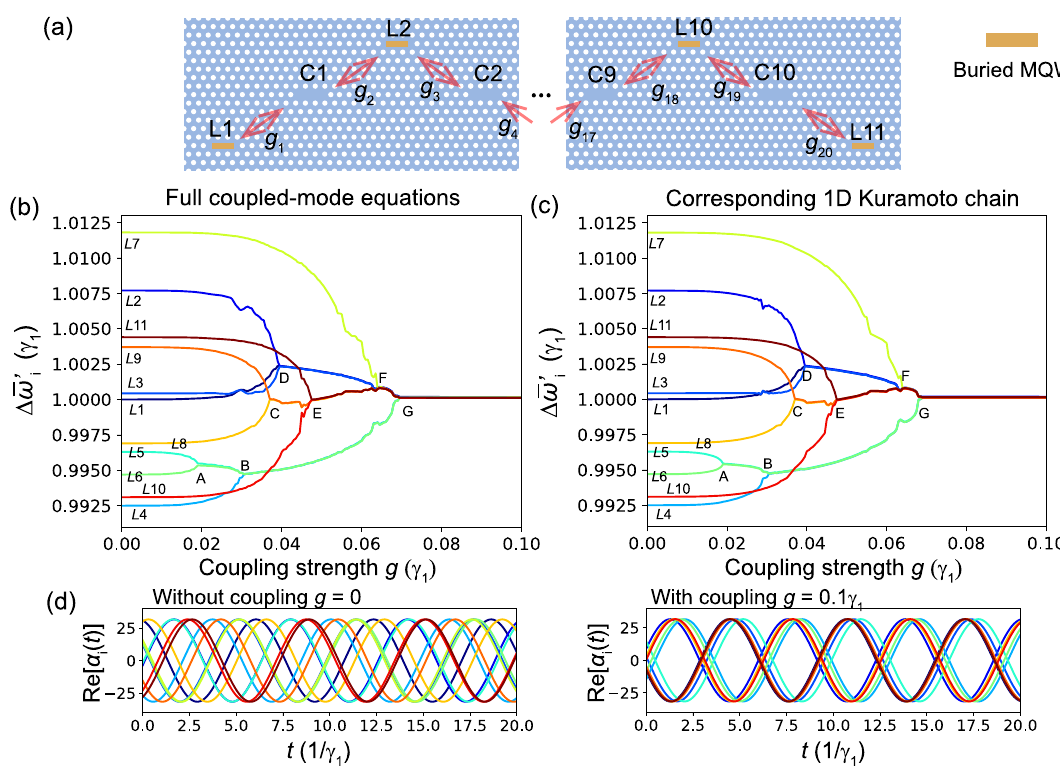
Figure 4. ( a ) Schematic of a chain of eleven indirectly coupled PhC lasers that emulates the Kuramoto chain. Indices L i and C i represent the i th laser and cold cavities, respectively. The shifted resonance frequencies of the laser cavities are ω ′ 1 = 1.0000, ω ′ 2 = 1.0077, ω ′ 3 = 1.0004, ω ′ 4 = 0.9925, ω ′ 5 = 0.9963, ω ′ 6 = 0.9947, ω ′ 7 = 1.0118, ω ′ 8 = 0.9969, ω ′ 9 = 1.0037, ω ′ 10 = 0.9931, and ω ′ 11 = 1.0044, where the units are γ 1 . For the other parameters, we use β i = 0.001 , ε i = 1.0 , γ i ≡ 1 , � i = 1 γ 1 and Ŵ i = γ 1 ≡ 1 for all i . ( c ) Synchronization tree calculated